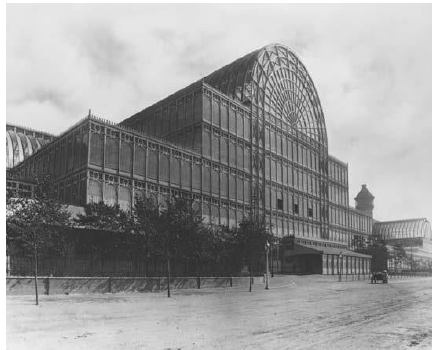
Figure 1. The crystal palace